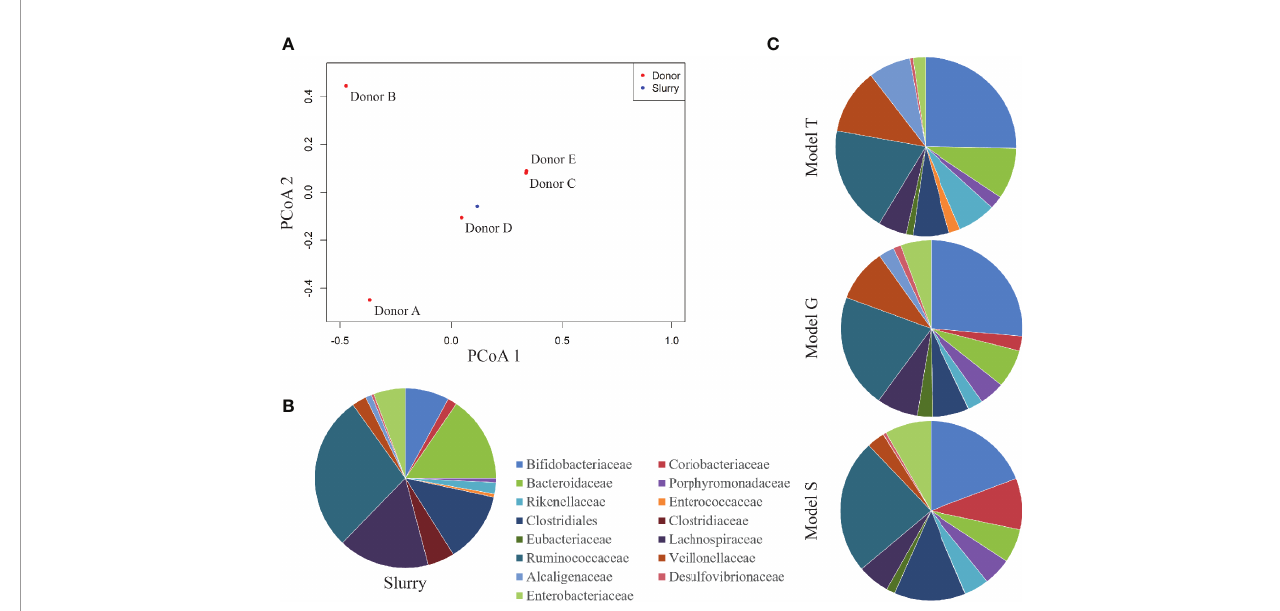
FIGURE 2 | Taxonomic analysis of the faecal donors, pooled slurry and the steady state from the three individual models. Principal coordinate analysis of the fi ve donors and the faecal slurry based on 16S rRNA sequencing (A) . Bacterial family abundance (%) found within the pooled faecal slurry used to initiate all models (B) and at end of steady state period (experimental day 14) from the three models (G, T and S) (C)